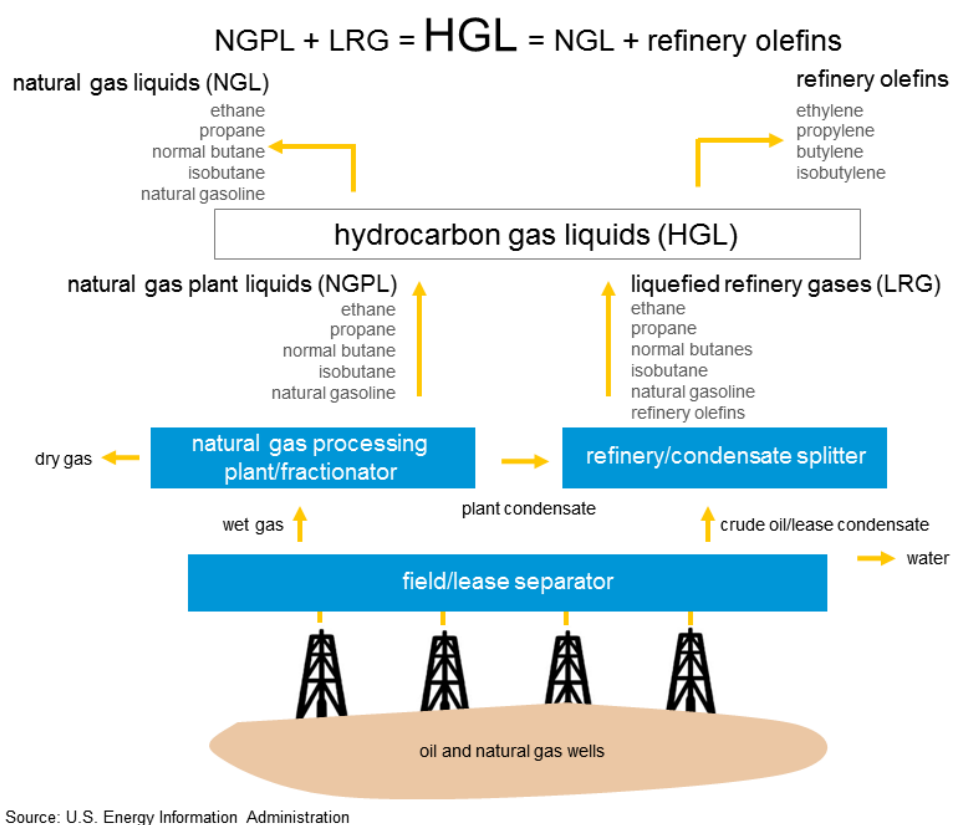
Figure 1. Sources of hydrocarbon gas liquids (HGL) and Natural gas liquids